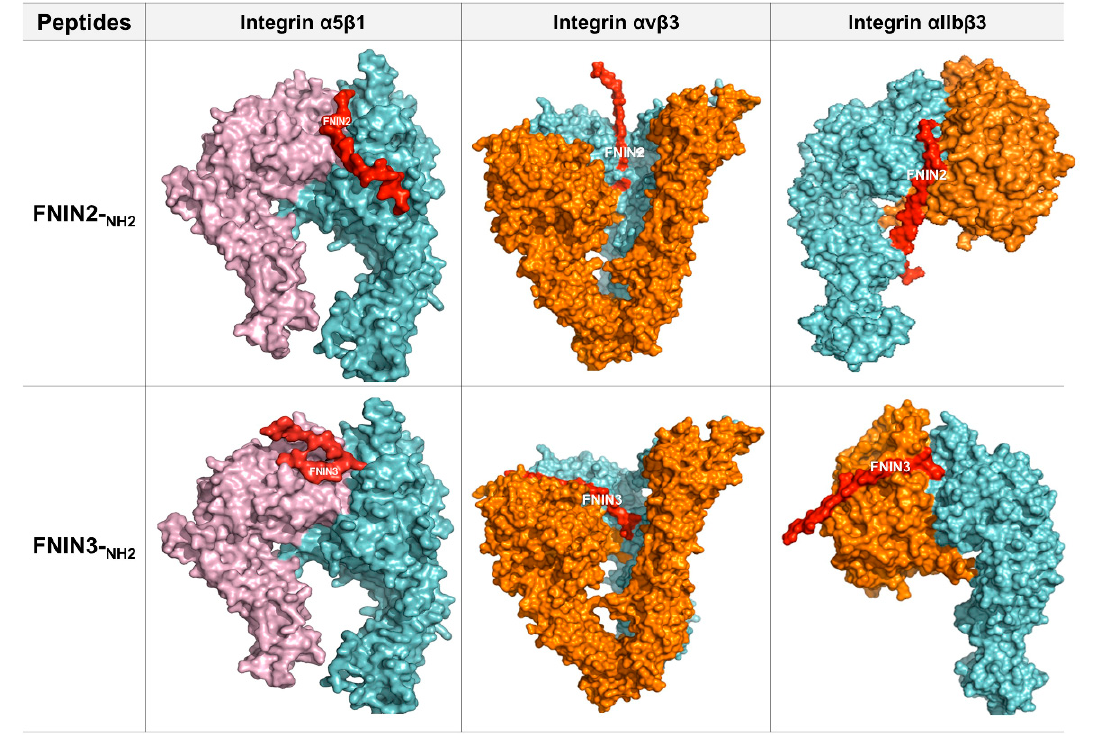
Figure 2. Molecular interactions between FNIN2 or FNIN3 and integrins. 3D visualization of FNIN2 or FNIN3 integrin ( α 5 β 1, α v β 3, and α IIb β 3).